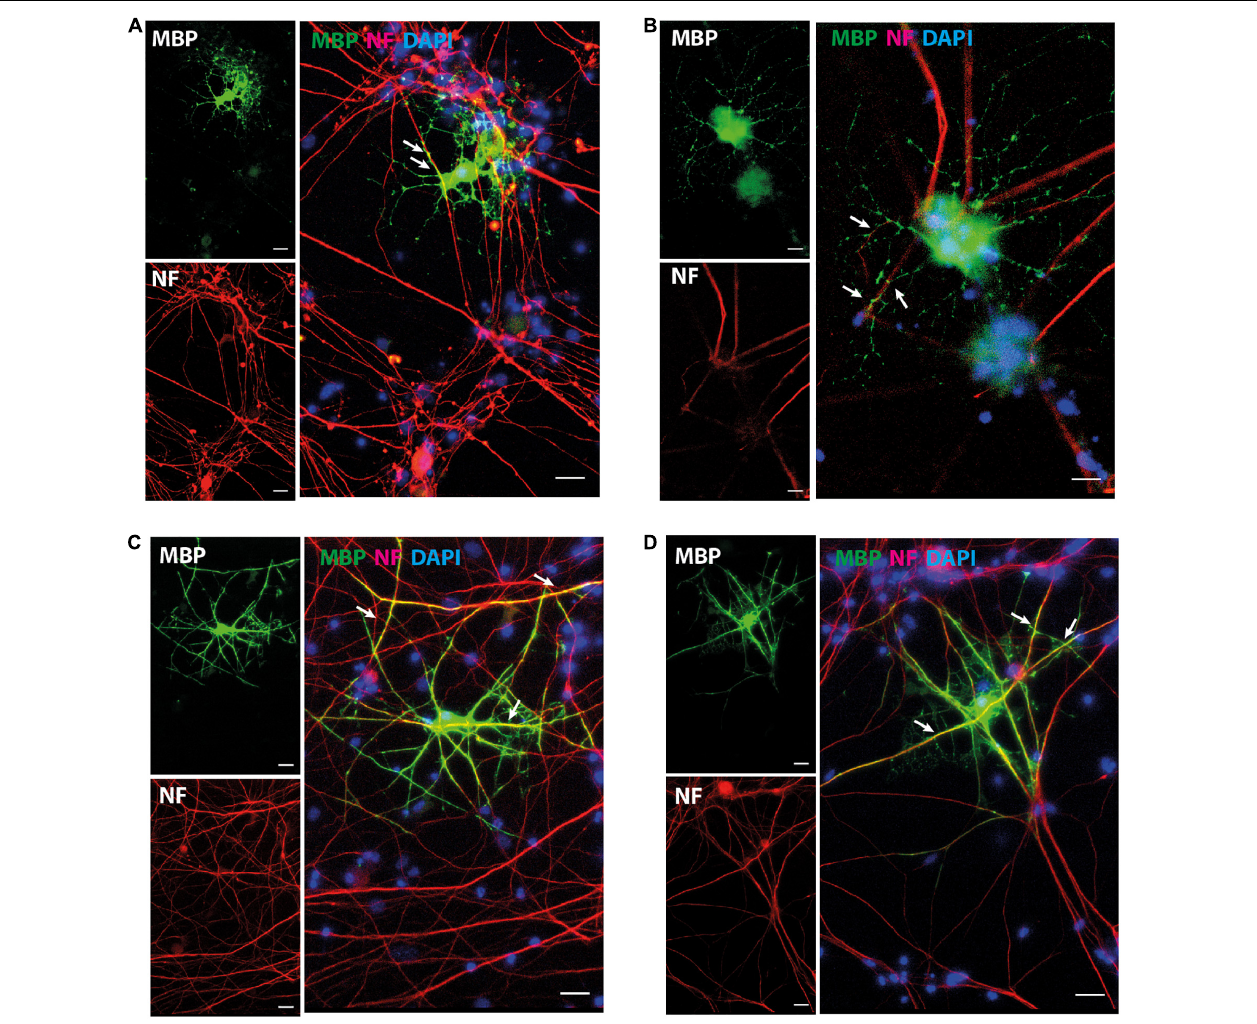
FIGURE 6 | NOP/OL initiate axonal contact in DRGN co-cultures. Representative images of immunofluorescent staining for myelin basic protein (MBP, myelin) and neurofilament heavy-chain polypeptide (NF, axons) in DRGN cultures seeded with NOP/OL (A,B) and pOPC (C,D) . After 7 days in co-culture, some NOP/OL have differentiated into MBP + OL whose processes contact DRGN axons. Contacts appear as fine MBP + process aligned with short stretches of NF + axon ( A,B , white arrows). pOPC show more advanced signs of myelination, with MBP + processes forming longer stretches of axonal alignment ( C,D , white arrows, yellow profiles). Nuclei were counterstained with DAPI. Scale bar: 20 µ